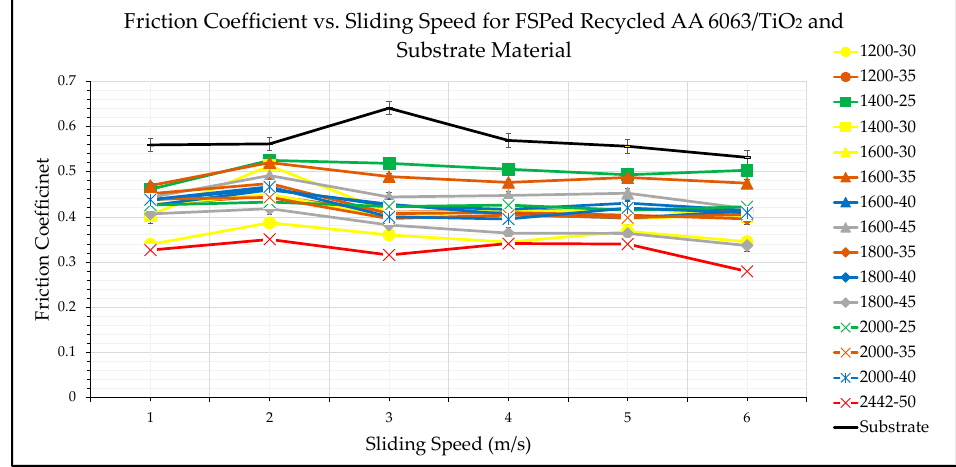
Figure 16. Friction coefficient against sliding speed for substrate material and FSPed samples subjected to a nominal contact pressure of 0.28 MPa for a test duration of 120 s under starved lubrication conditions.